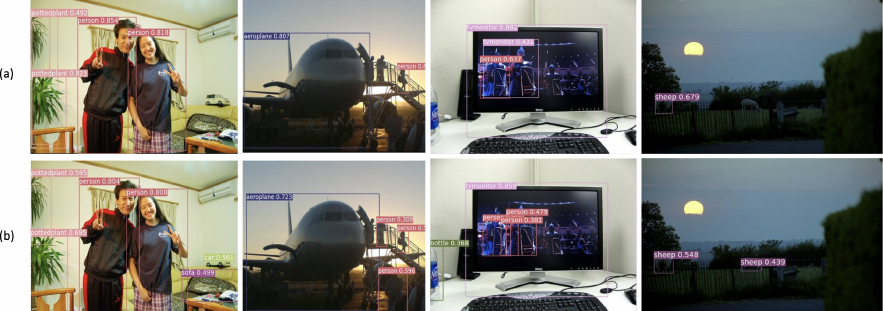
Figure 9. Detection results with the PASCAL VOC07 testing dataset by ( a ) the baseline FCOS and ( b ) the proposed method.